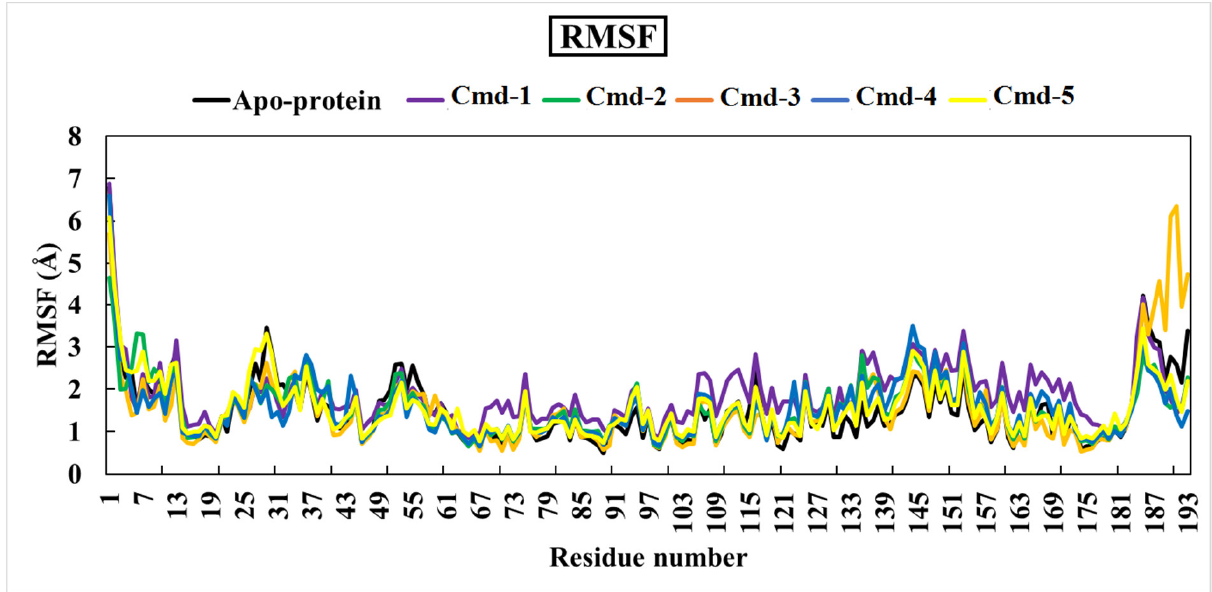
Figure 7. Root-mean-square-fluctuation (RMSF) of the apoprotein structure and five selected com- plexes (Omicron BA.1/Cmd-1, Omicron BA.1/Cmd-2, Omicron BA.1/Cmd-3, Omicron BA.1/Cmd-4, Omicron BA.1/Cmd-5).